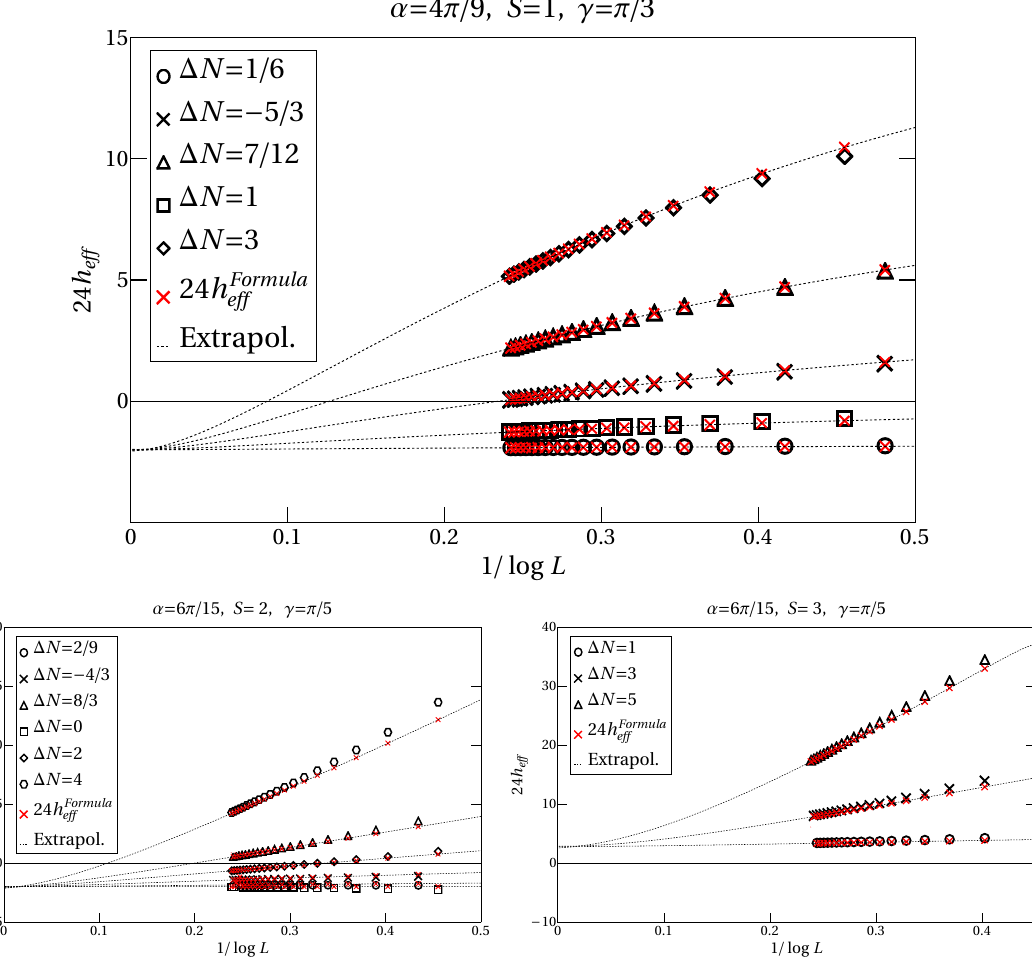
Figure 10 . Similar as figure 8 but for values of α away from the self-dual point ( ∆ N = dN − dN GS ). J , related to bound states localized near the tip of the cigar-shaped target space of the model [11, 12, 36]. For the corresponding states to be normalizable and to guarantee non- negative conformal weights the possible values of J are restricted to obey the following